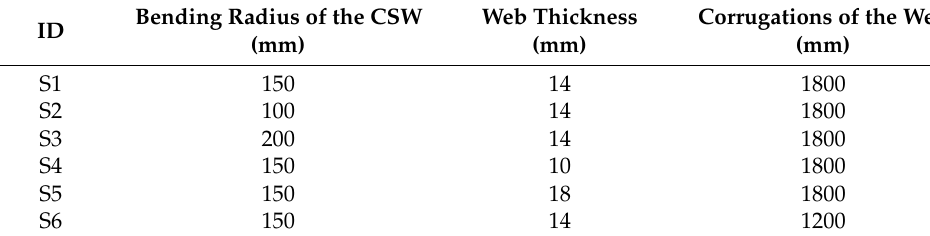
Figure 16. Schematic diagram of the design parameters.